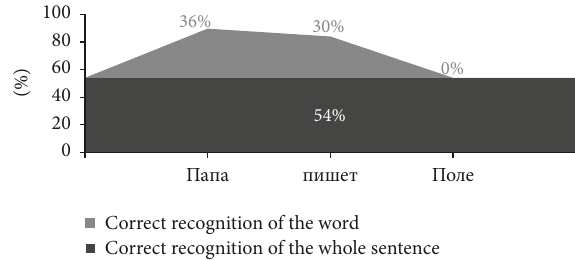
Figure 16: Recognition of isolated words in the phrase « ^1_1 _Ke e g ^]S e» (Eng.: Father writes to Polya) against pink noise [Base: 𝑛 = 247